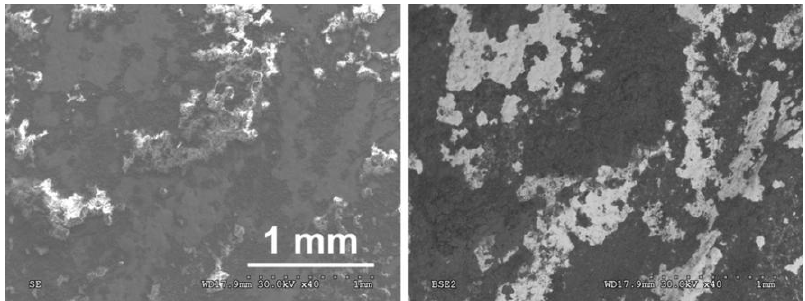
Figure 16. SEM images of the surface of the wing of the putto with the laurel (Figure 15) in SE mode (left) and BSE mode(right).